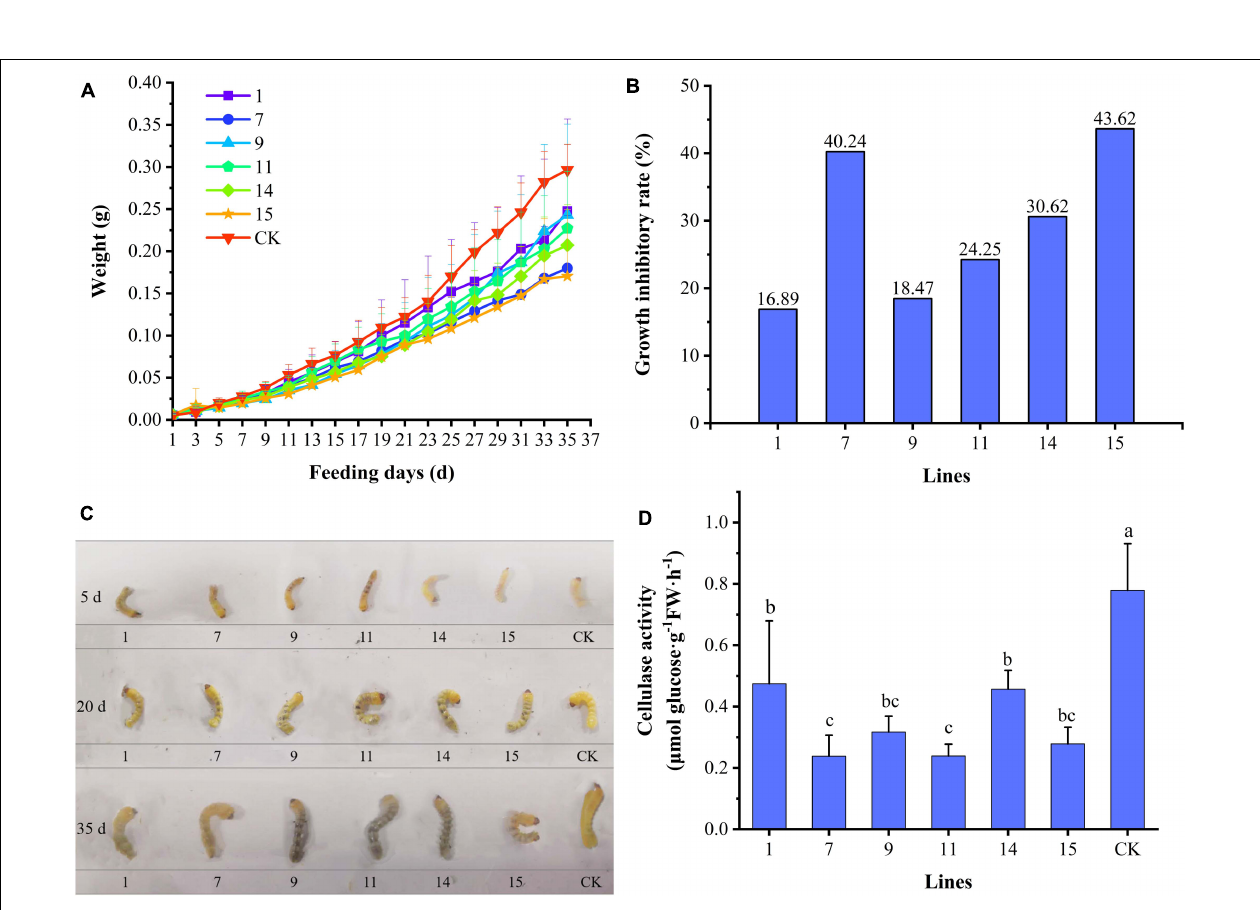
FIGURE 3 | Resistance of transgenic lines to target insects. M . troglodyta L1 larvae were not fed lines 3, 12, or 13.